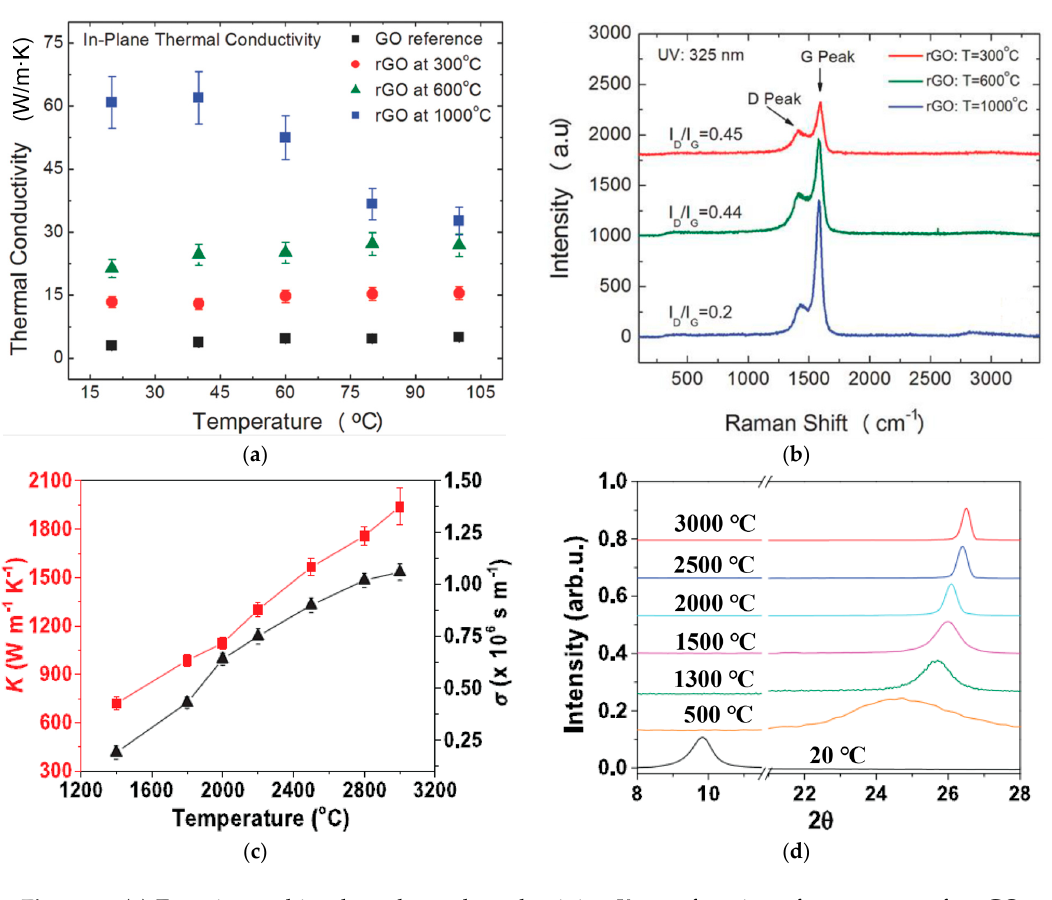
Figure 7. ( a ) Experimental in-plane thermal conductivity, K , as a function of temperature for rGO films annealed at different temperatures and a reference GO film. ( b ) Raman spectra of rGO films under UV ( λ = 325 nm) laser excitations. The peaks at ≈ 1350 and 1580 cm − 1 correspond to the D and G peaks, respectively. ( c ) The thermal (red line) and electrical conductivity (black line) of rGO films annealed at different temperatures. ( d ) XRD patterns of rGO films annealed at different temperatures. ( a , b ) Reprinted from [38] with permission, Copyright 2015 Wiley Online Library; ( c , d ) Reprinted from [28] with permission, Copyright 2017 Wiley Online Library.